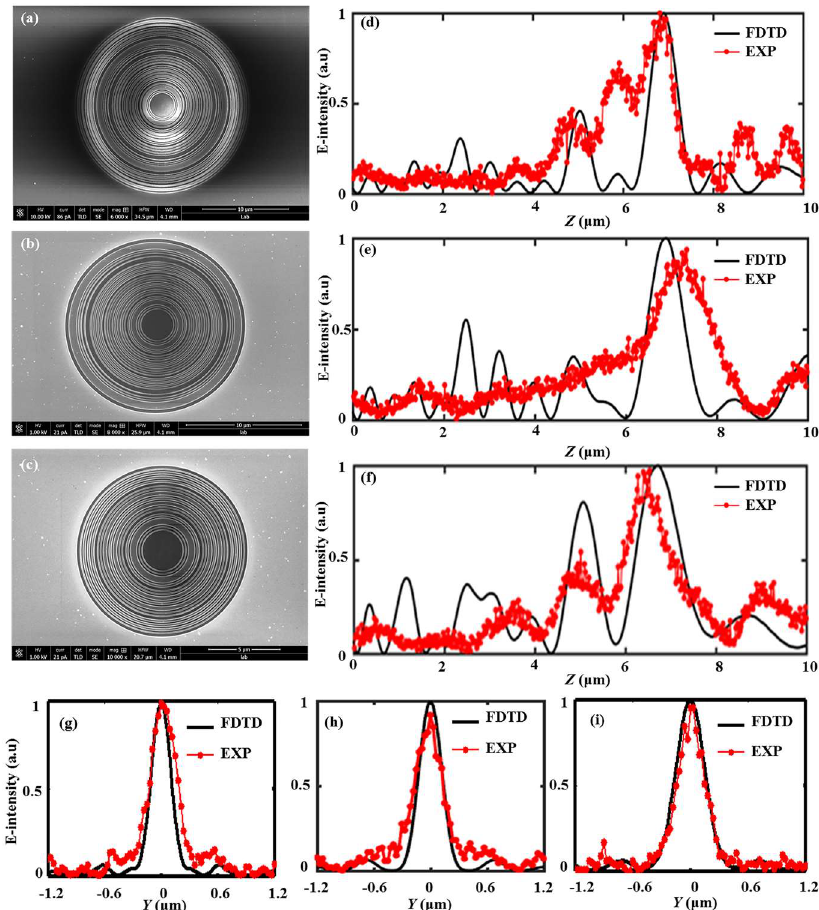
Figure 11. SEM images of the three samples (( a ) R = 10 μm, ( b ) R = 8 μm, ( c ) R = 6 μm) and the corresponding axial intensity distribution along the optical axis for ( d ) #2-1, ( e ) #2-2, and ( f ) #2-3; Bottom: The normalized intensity line of the hotspots with their FWHMs for ( g ) #2-1, ( h ) #2-2, and ( i ) #2-3.